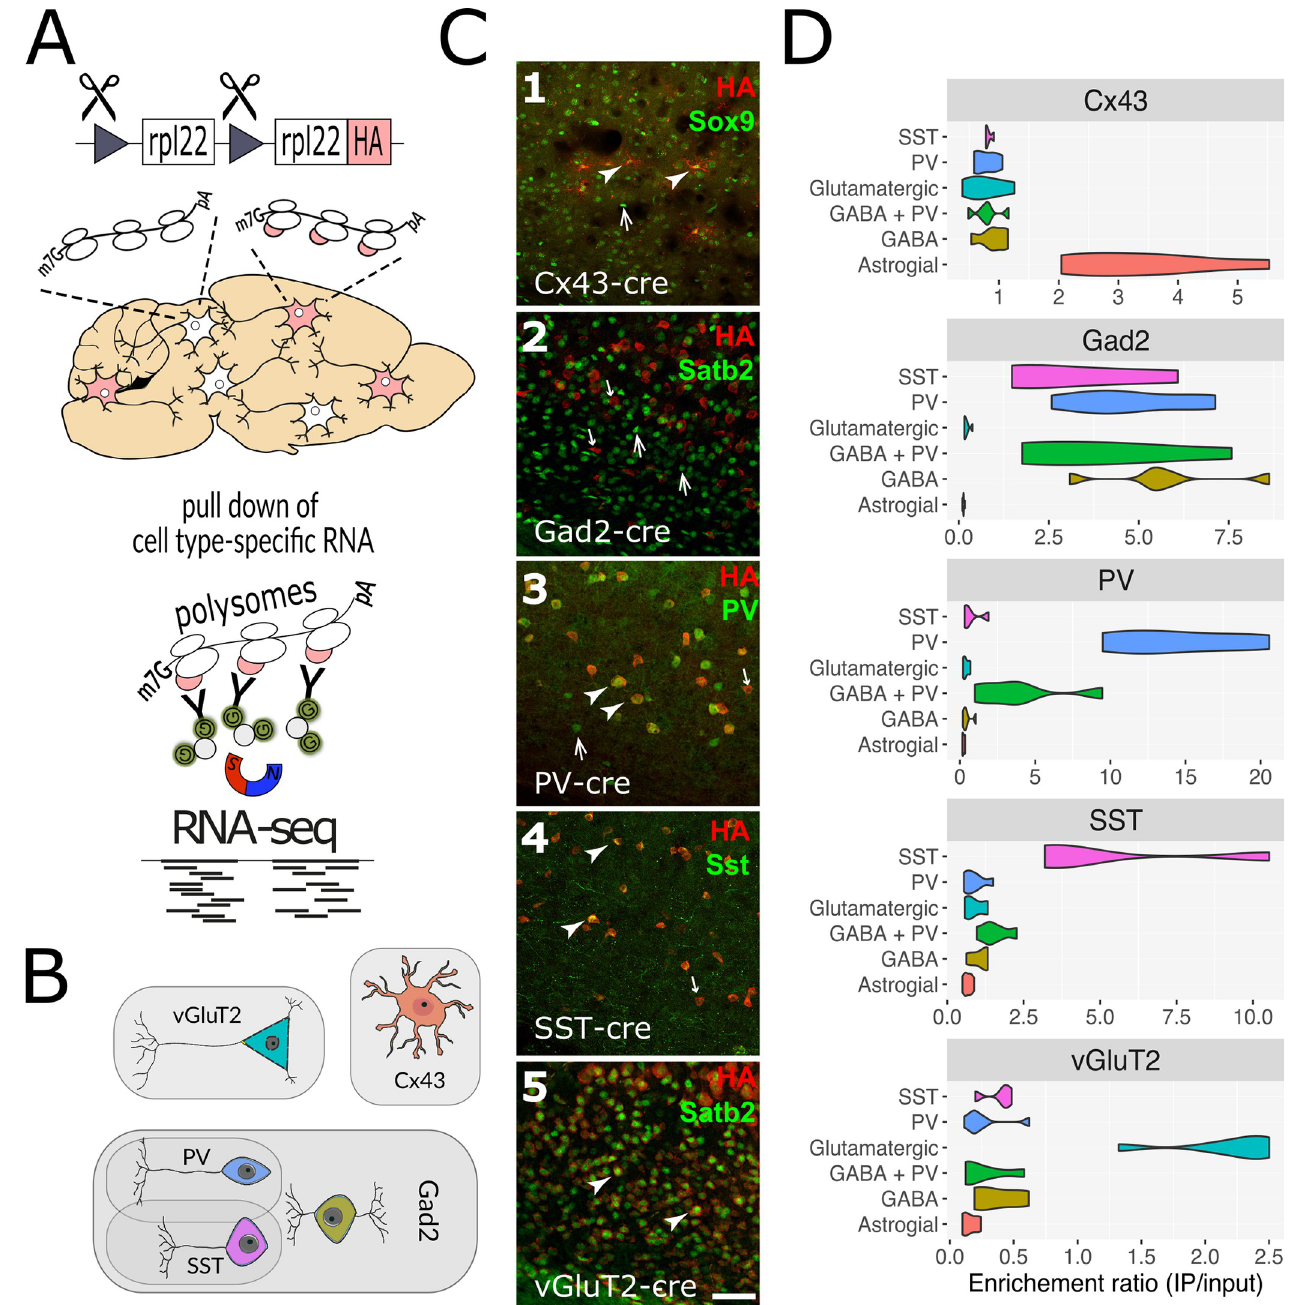
Fig 2. RiboTag activation and validation. ( A ) The RiboTag system is activated in cells with Cre activity through site-directed recombination in Rpl22 to make Rpl22-HA (RiboTag). Frozen mouse brain tissue is homogenized, creating a mix of mRNAs attached to either normal ribosomes (white oval bubbles) or RiboTagged ribosomes (white oval bubbles with pink tags) made specifically by Cre+ cells. Cell-type-specific, ribosome associated mRNA is isolated by RiboTag IP with HA antibody and protein G magnetic beads. mRNA from Cre+ cells is then sequenced. ( B ) Cell types used in these studies. Shaded areas reflect the expression overlap between Gad2, PV and SST Cre lines. ( C ) Confocal images of cortex following double immunofluorescence labeling of HA (RiboTag) and representative histological cell-type markers. Cell type markers used (from 1 to 5 respectively): Astrocytes (Sox9), GABAergic cells (Satb2; glutamatergic cell marker to highlight the lack of colocalization with GABAergic neurons), PV neurons (PV), SST neurons (Sst), glutamatergic neurons (Satb2). Examples for double-positive cells are indicated by arrowheads, HA-/marker+ cells by upward pointing arrows, HA+/marker- cells by downward pointing and smaller arrows. Scale bar indicates 50 μ m (identical for all panels). C1: specific HA-labeled astrocyte-like shaped cells colocalize with Sox9 in Cnx43-Cre/RiboTag mice. C2: Complete separation of HA and the glutamatergic marker, Satb2, in Gad2-Cre/RiboTag mice was observed. C3: PV and HA show substantial colocalization in PV-Cre/RiboTag mice. C4: All Sst+ cells were co-labeled for HA, although there were several HA+/SST- cells in SST-Cre/